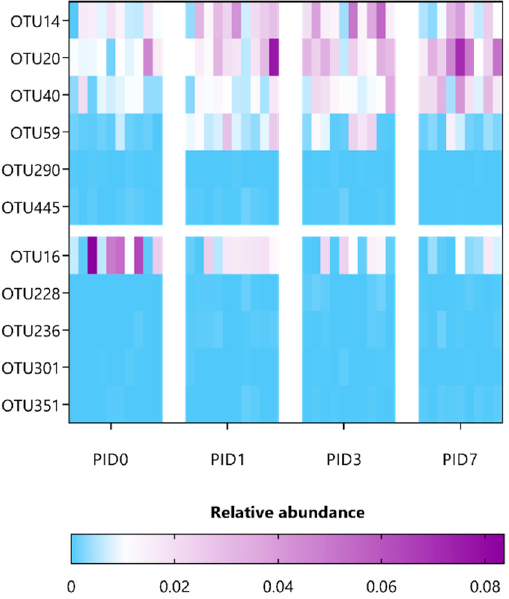
Figure 11. Heatmap representing the relative abundance of significant gut microbial dysbiosis markers detected L. rhamnosus GG-given mice following sham-irradiation as listed in Table 3, n = 10 per time point. OTU = operational taxonomic unit; PID = post-irradiation day .